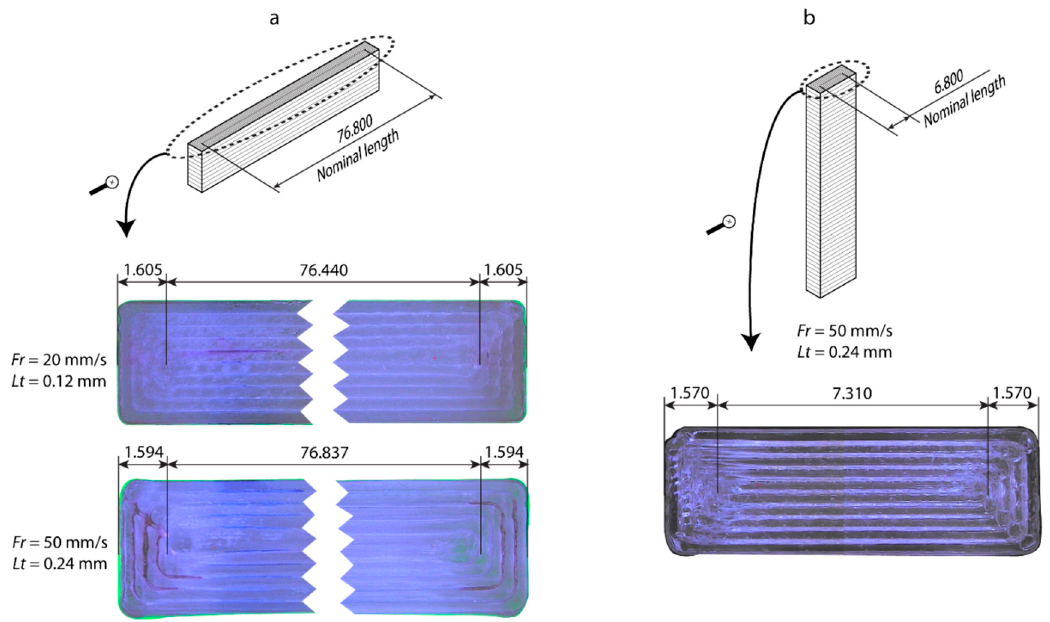
Figure 5. Details of the incorrect length of the central filament on the upper layer: ( a ) Flat and ( b ) upright orientation.